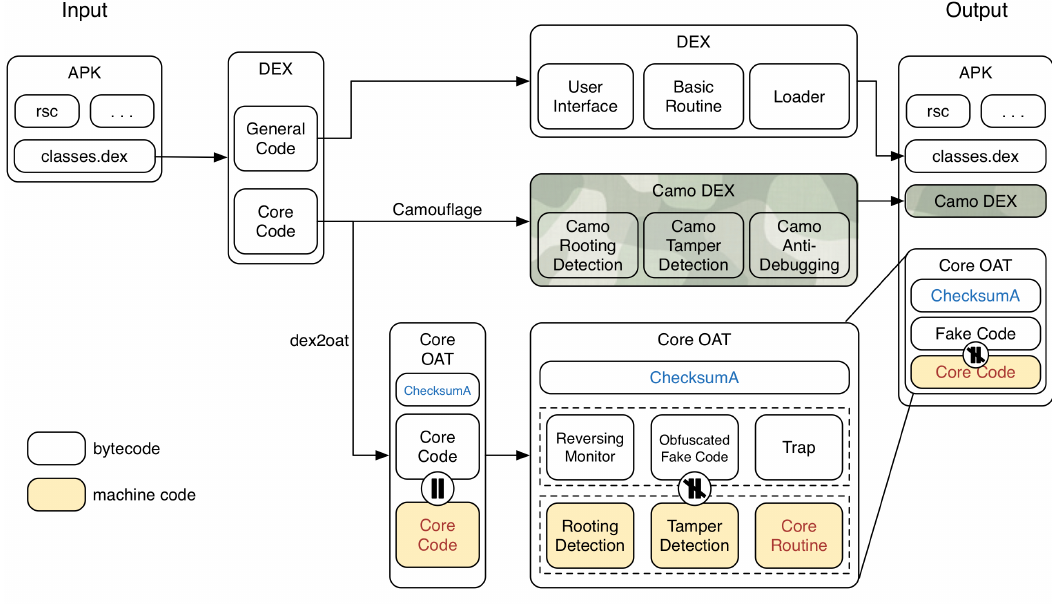
Figure 13. Proposed system